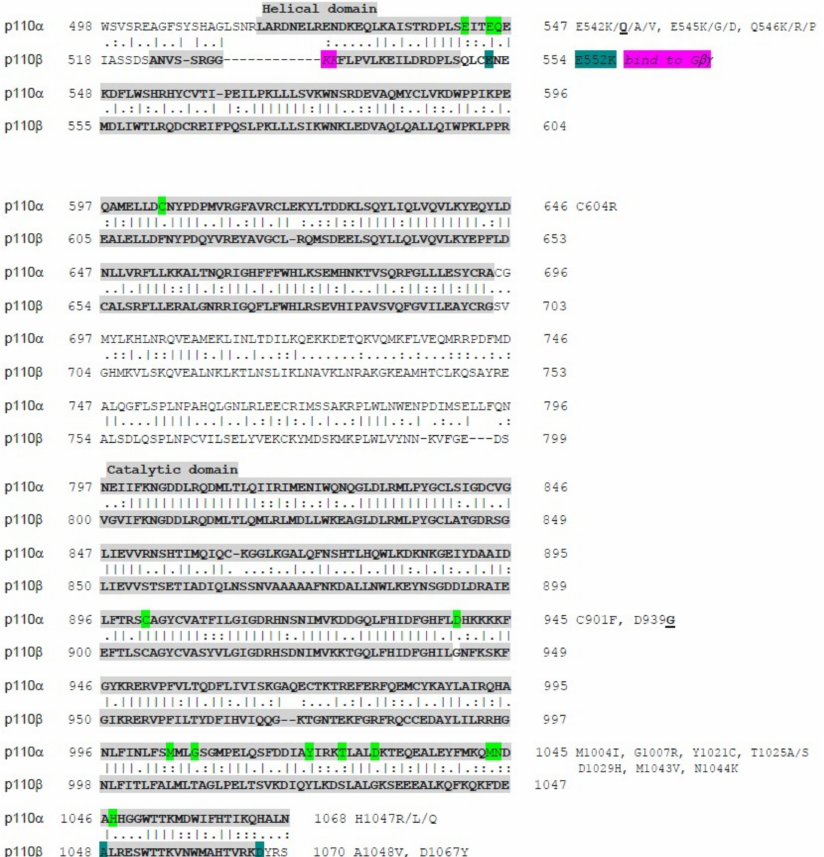
Figure A1. Alignment of human p110 α (UNIPROT P42336) and p110 β (UNIPROT P42338) protein sequences using the pairwise sequence alignment web tool EMBOSS Needle. Mutations identified in the TCGA genome-wide sequencing in endometrial cancer are highlighted here for both isoforms with different colour